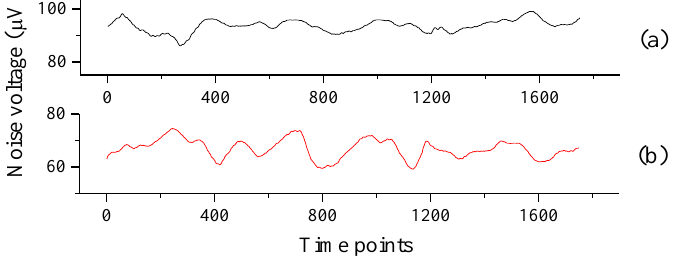
Figure 4. Noise in different resonant conditions; ( a ) system noise when both AR1 and AR2 were used; ( b ) system noise when only AR1 was used.